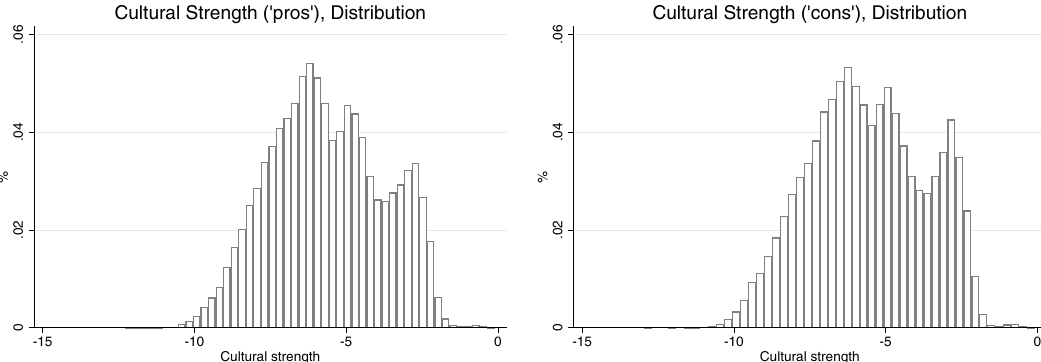
Fig. 2 Cultural strength distribution. In Fig. 2, we represent the distribution of the cultural strength metric, computed on “ pros ” in the left panel and on “ cons ” section of Glassdoor reviews in the right panel.